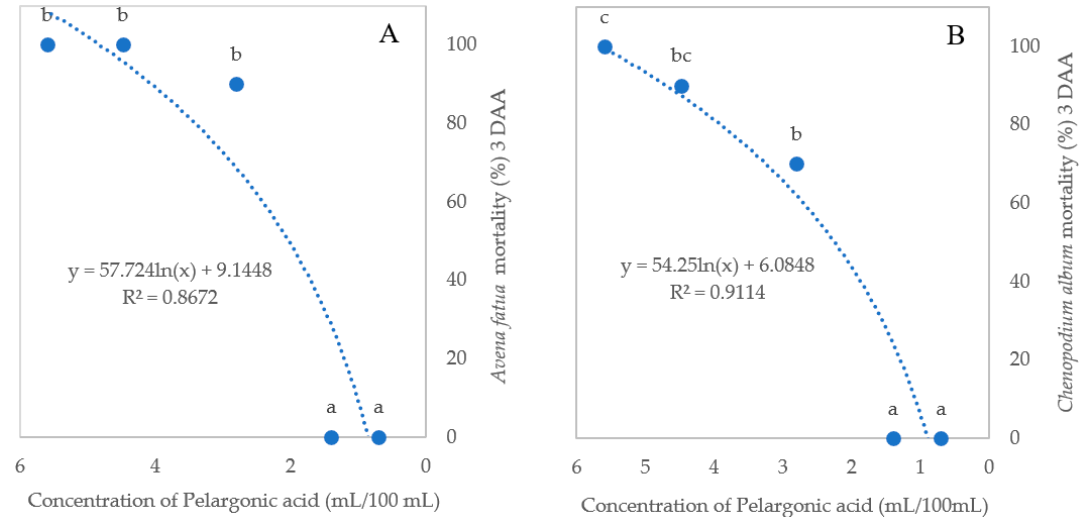
Figure 3. Dose–response curve of PSEI against Avena fatua ( A ) and Chenopodium album ( B ) three days after treatment application (3DAA) under greenhouse conditions. Mortality was assessed as percentage of death plants per plot. Different letters mean statistical differences between concentrations.